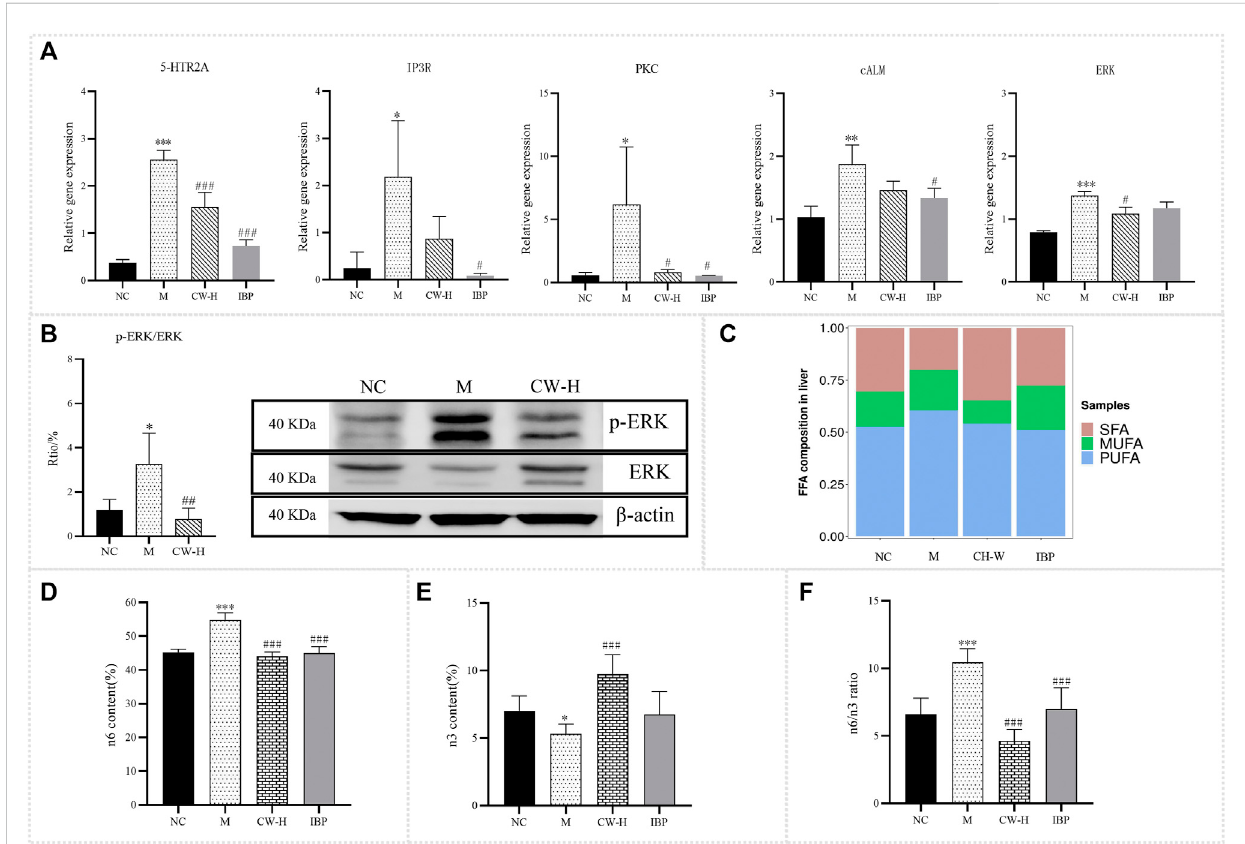
FIGURE 5 RT-qPCR, WB, and FA metabolomics results of CW against PD. (A) Gene expression levels of 5-HTR2A, IP3R, PKC, cALM, and ERK in the uterine tissues of rats in each group (x ‾ ± s, n = 3). (B) Protein expression levels of p-ERK and ERK in the uterine tissues of rats in each group (x ‾ ± s, n = 3). (C) The proportionofSFA,MUFA,andPUFAinlivertissues(x ‾ ±s, n =6). (D) n6PUFAs(x ‾ ±s, n =6). (E) n3PUFAs(x ‾ ±s, n =6). (F) n6/n3ratio(x ‾ ±s, n =6).Compared withtheNCgroup,* p < 0.05,** p < 0.01,*** p < 0.001;comparedwiththeMgroup, # p < 0.05, ## p < 0.01, ### p <